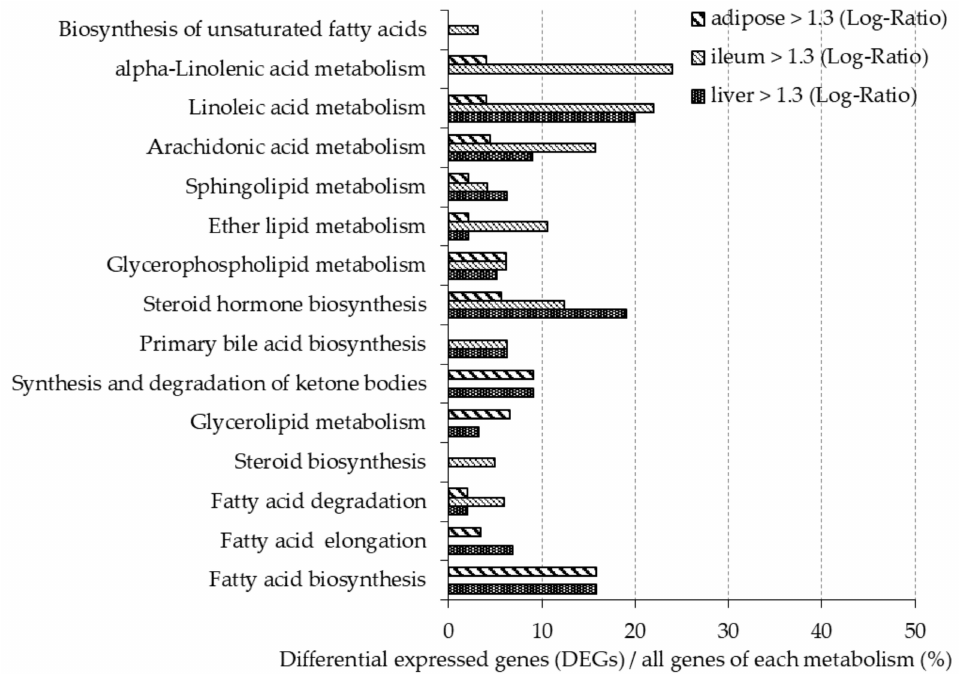
Figure 2. In mice fed the BF diet, the ratio of Di ff erential Expressed Genes (DEGs) upregulated (gene expression > 1.3-fold di ff erence compared with the control group) in each organ is shown. The y -axis shows the lipid metabolic pathway described in Kyoto Encyclopedia of Gene and Genome (KEGG). The x -axis shows the percentage of the DEGs of all genes involved in each metabolic